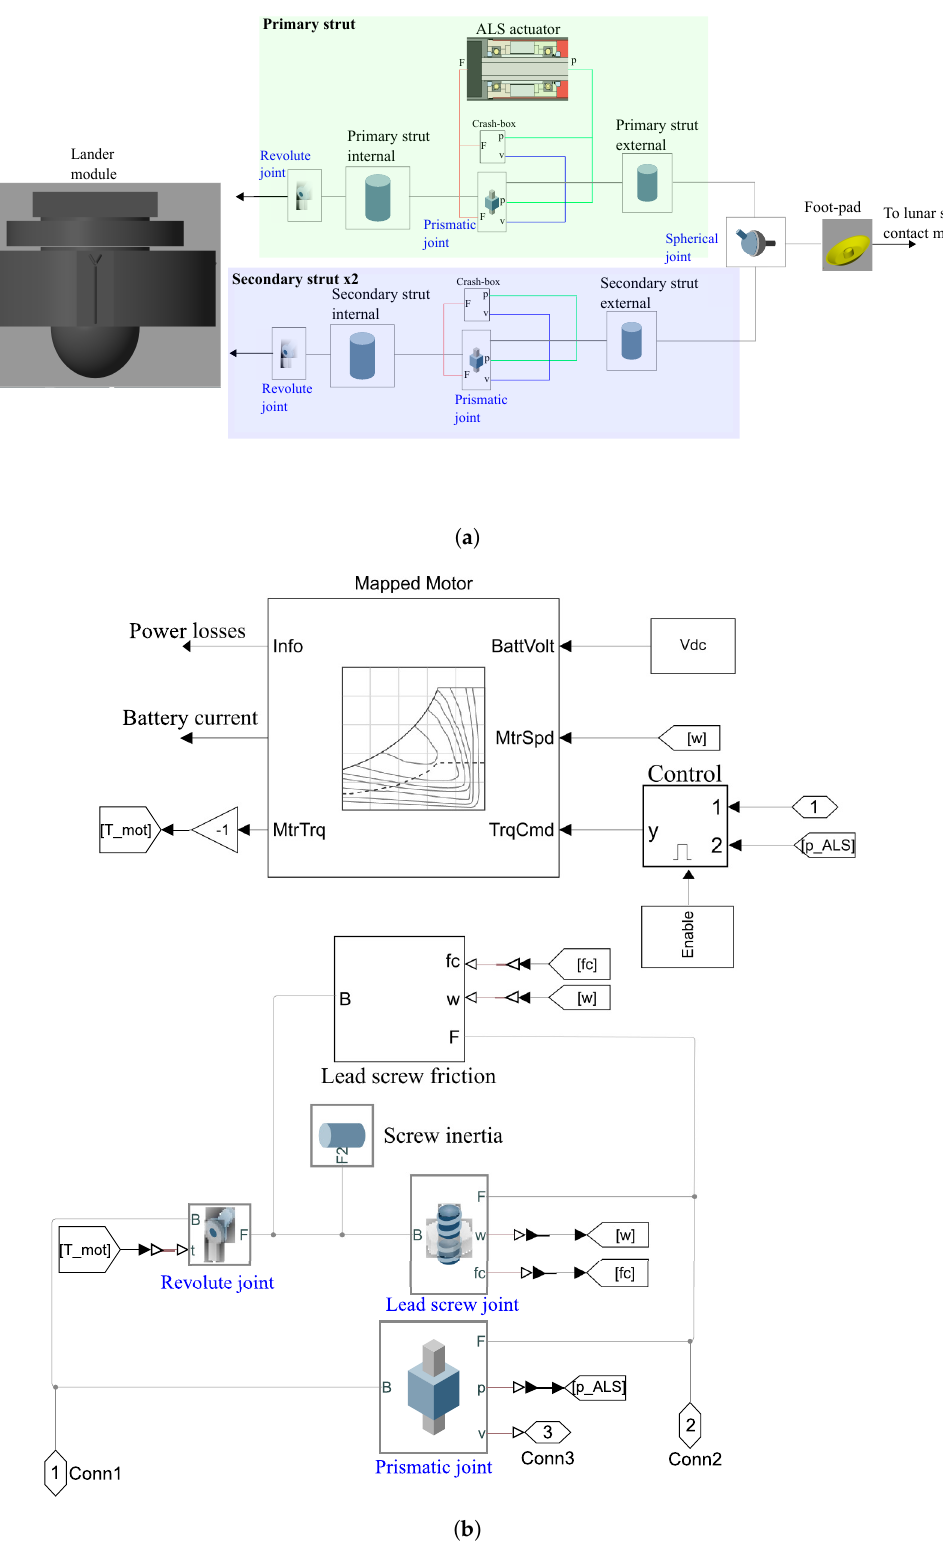
Figure 4. Multi-body model of the landing gear ( a ). ALS subsystem ( b